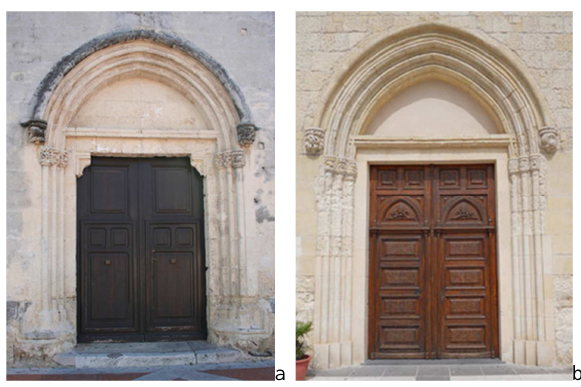
Figure 1. Studied portals: a) Assemini, San Pietro; b)